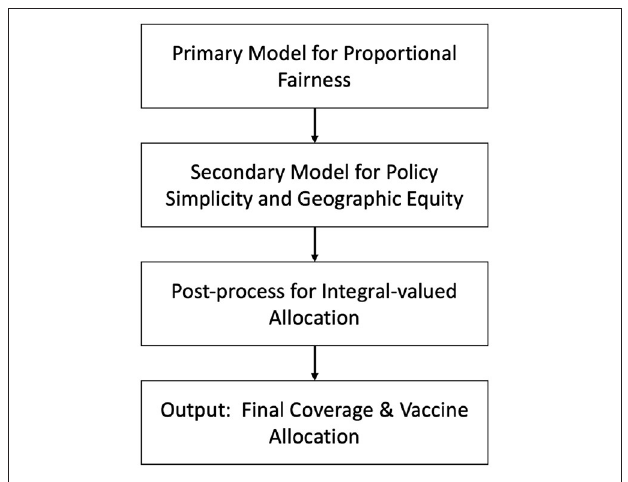
FIGURE 6 | Model for allocating vaccines of multiple types to priority groups at multiple locations (